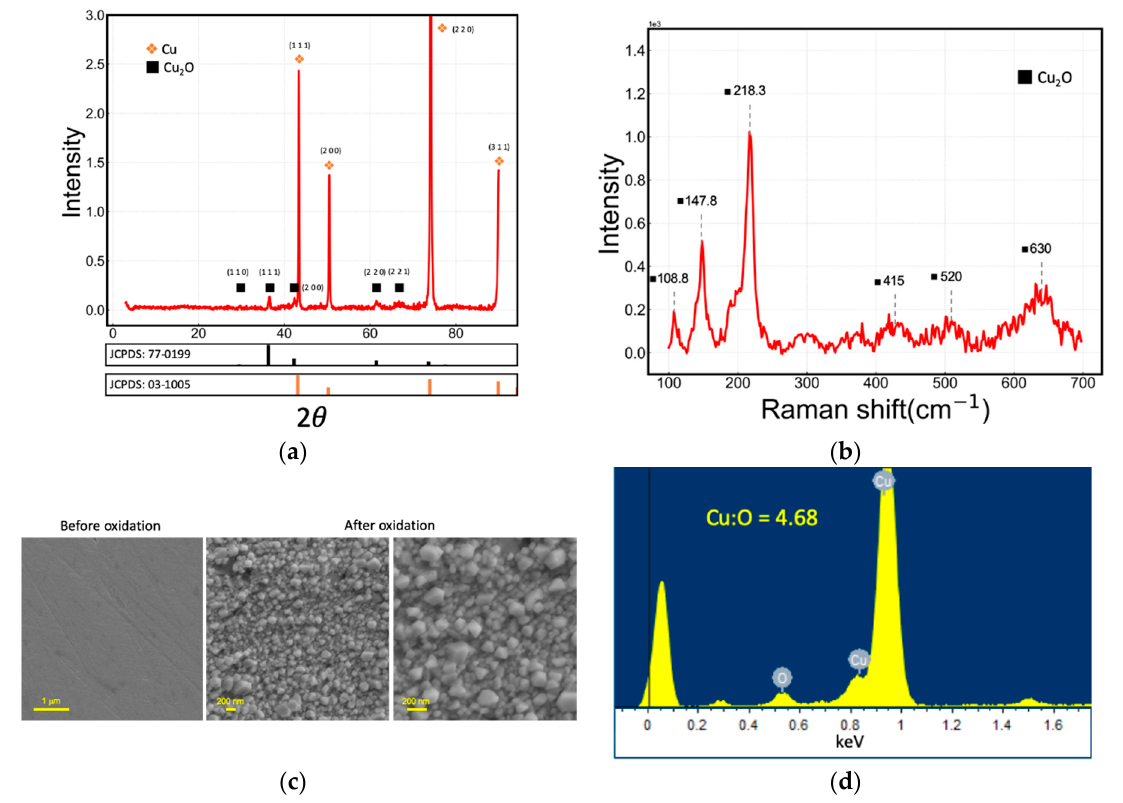
Figure 1. ( a ) XRD pattern, ( b ) Raman spectrum, ( c ) SEM images of the newly in situ fabricated Cu 2 O electrode, and ( d ) energy-dispersive X-ray spectroscopy (EDS) analysis.